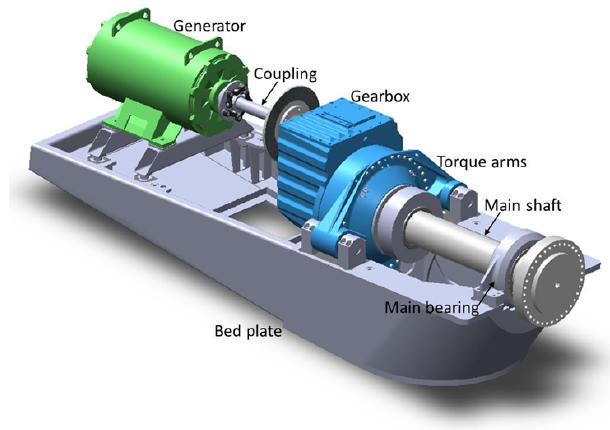
Figure 1. Gearbox Reliability Collaborative drivetrain configura-